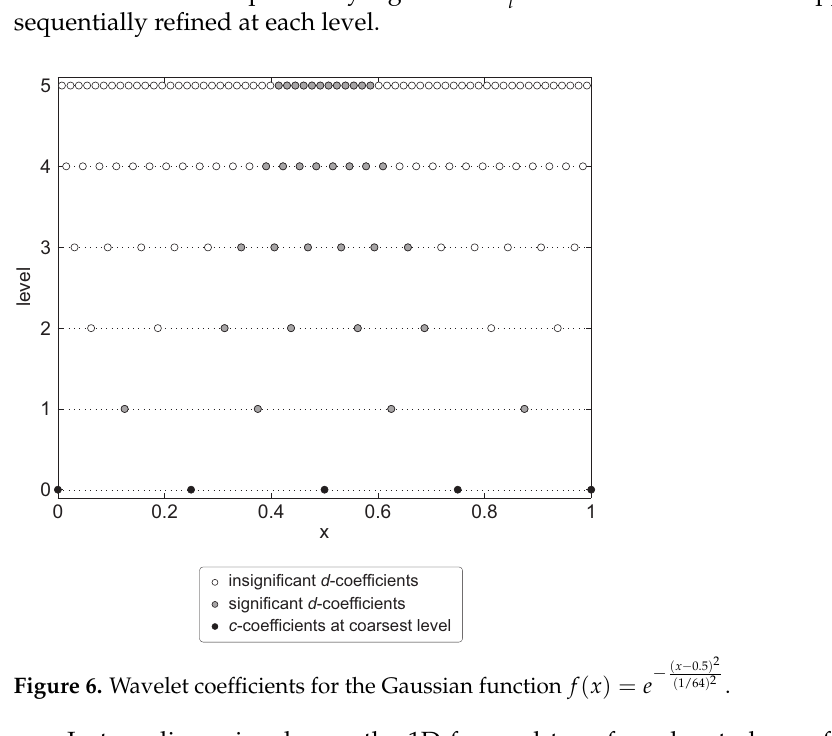
Figure 6. Wavelet coefficients for the Gaussian function f ( x ) = e